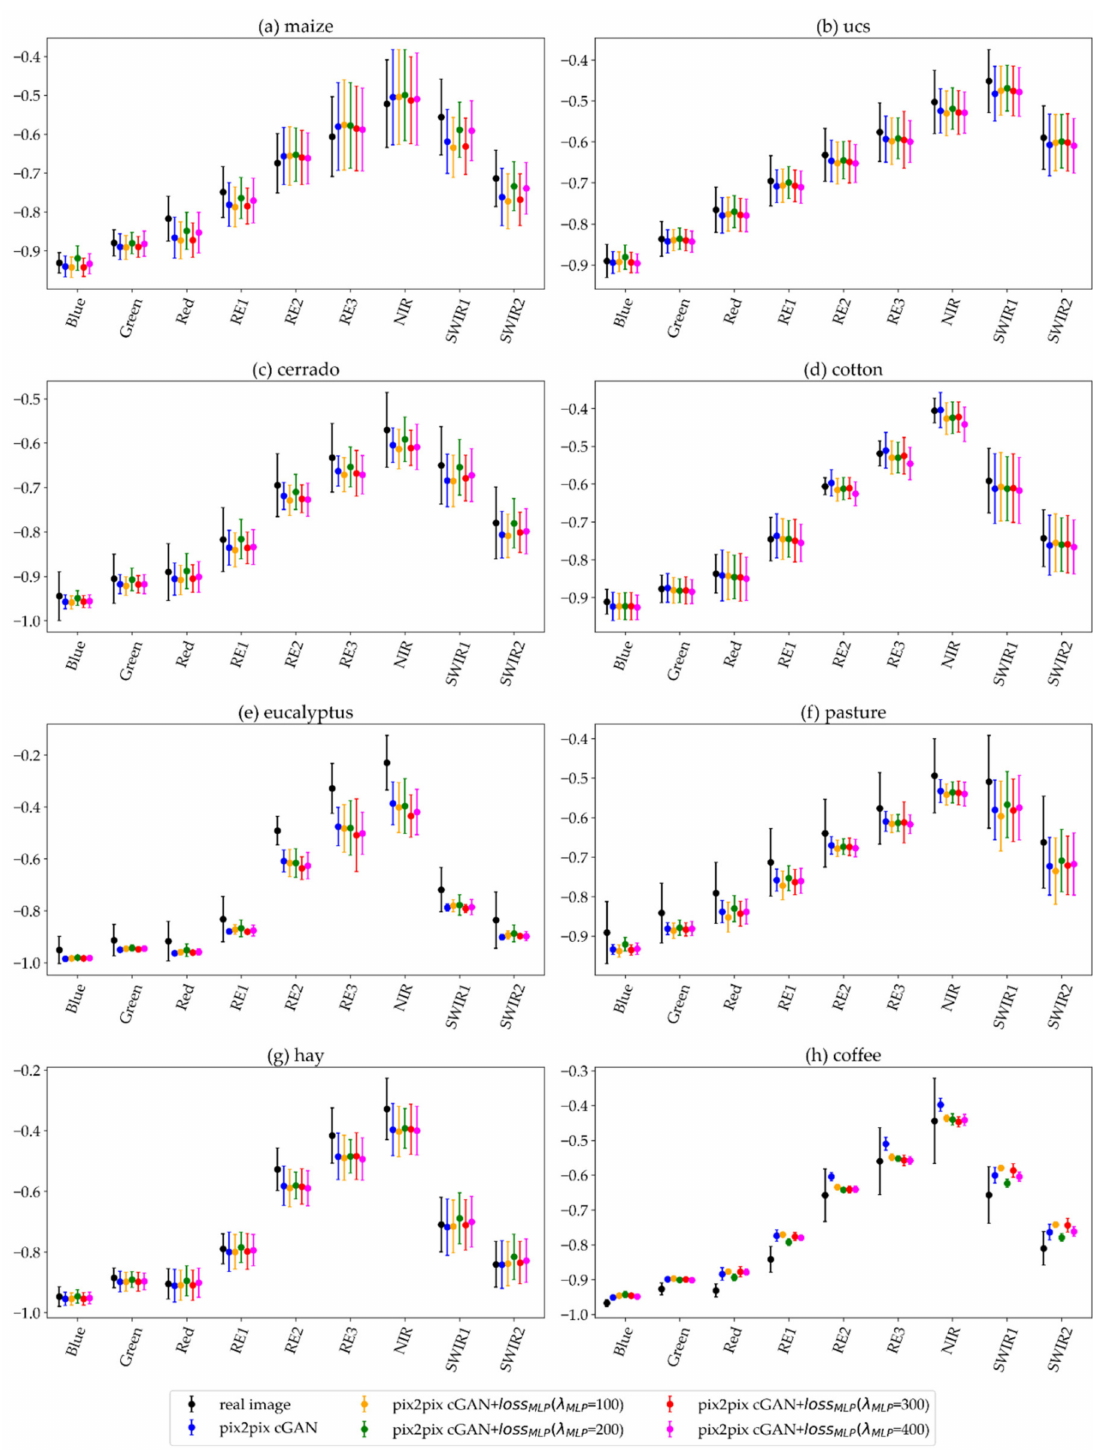
Figure 10. Pixel values comparison between the real and synthetic images produced with the original pix2pix cGAN (I-A) and the proposed approach with λ MLP equal to 100 (I-B) , 200 (I-C), 300 (I-D) and 400 (I-E) for the classes: ( a ) maize; ( b ) UCS; ( c ) cerrado; ( d ) cotton; ( e ) eucalyptus; ( f ) pasture; ( g ) hay; and ( h )